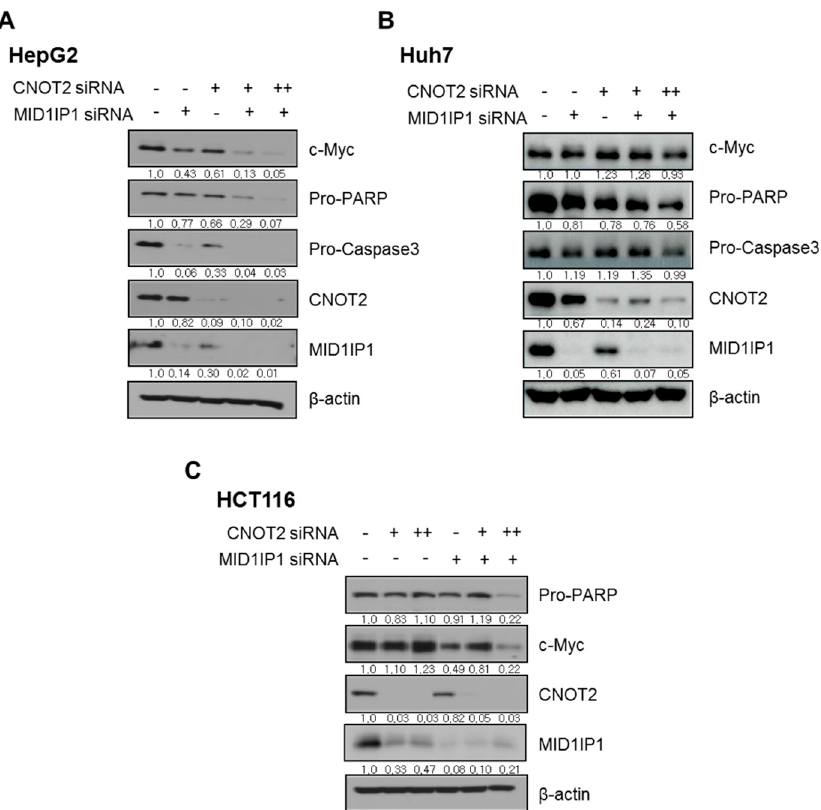
Figure 7. CNOT2 knockdown enhances antitumor effect of MID1IP1 depletion in HepG2, Huh7 and HCT116 cells. ( A ) Effect of CNOT2 knockdown on inhibitory effect of MID1IP1 depletion on c-Myc, pro-PARP and pro-Casapse3 in HepG2 cells. ( B ) Effect of CNOT2 knockdown on inhibitory effect of MID1IP1 depletion on c-Myc, pro-PARP and pro-Casapse3 in Huh7 cells. ( C ) Effect of CNOT2 knockdown on inhibitory effect of MID1IP1 depletion on c-Myc and pro-PARP in HCT116 cells. Concentration of CNOT2 siRNA; + (5 nM), ++ (10 nM) and concentration of MID1IP1 siRNA; + (40 nM). Values of Western blot images represent relative level of protein expression/ β -actin.